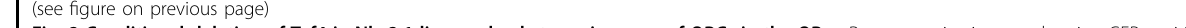
Fig. 2 Conditional deletion of Tcf4 in Nkx2.1 lineage leads to an increase of OPCs in the OB. a Representative images showing GFP-positive cells from WT and Tcfk4 cKO OB. Scale bar: 100 μ m. b Quanti fi cation of the distribution of GFP-positive cells. Student ’ s t test was used to compare two groups. Data are presented as mean ± SEM. * p < 0.05, ** p < 0.01, and *** p < 0.001 ( n = 4). c Representative images of RFP and Olig2 staining in WT and Tcf4 cKO OBs at P28. Small monochannels are the higher magni fi cation of the solid square boxes. White arrowheads represent the GFP + Olig2 + cells and yellow arrowheads mark GFP − Olig2 + cells. Scale bar: 50 μ m. d – g Quanti fi cations of Nkx2.1-derived Olig2-positive cells ( d ) and their distribution in each layer of the OB ( e ), the number of non-Nkx2.1 derived Olig2-positive cells ( f ), and the total number of Olig2-positive cells in the OB ( g ). Student ’ s t test was used to compare two groups. Data are presented as mean ± SEM. * p < 0.05, ** p < 0.01, n.s. nonsigni fi cant. At least three samples were analyzed for each condition. h Diagram shows molecular markers expressed during OPC development. i Representative images show the immunostaining for GFP, Sox10, CC1, and NG2. White arrowheads indicate GFP + Sox10 + cells negative for CC1. j Quanti fi cation of cells is positive for either Sox10 or NG2 or CC1. k Representative images show the immunostaining for GFP, GFAP, and Sox9. Yellow arrowheads indicate GFP- positive cells which are negative for GFAP and Sox9. Scale bar: 50 μ